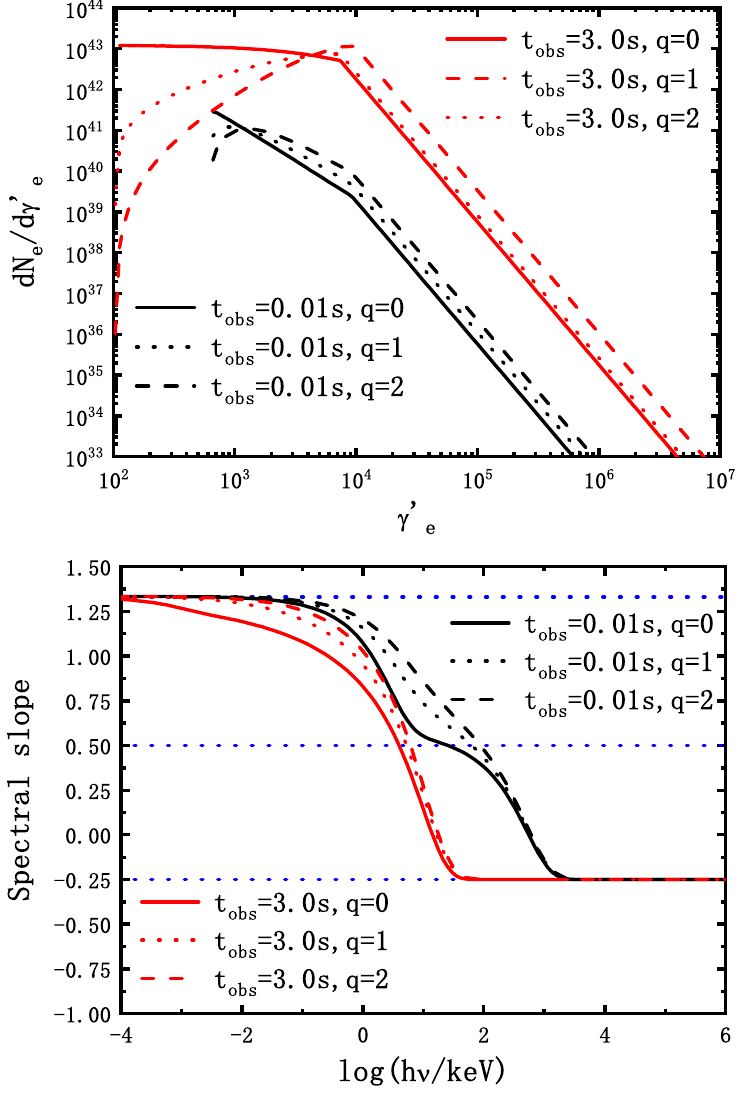
Figure 4. The top panel shows the electron distributions in evolutional magnetic fields and different electron injection rising indices. We adopt the electron injection rising index, q = 0 (solid line), q = 1 (dotted line) and q = 2 (dashed line). The bottom panel shows the corresponding synchrotron spectral slopes for these electron distributions. The same parameters as in Figure 1 are taken for numerical